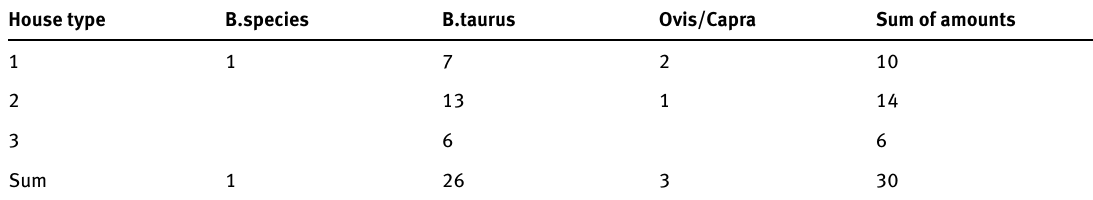
Table 1b: Bylany (distr. Kutná Hora), pottery phases 1 to 8. Frequency of animal bones in house types. Data after Peške, Rulf, Slavíková (1998).